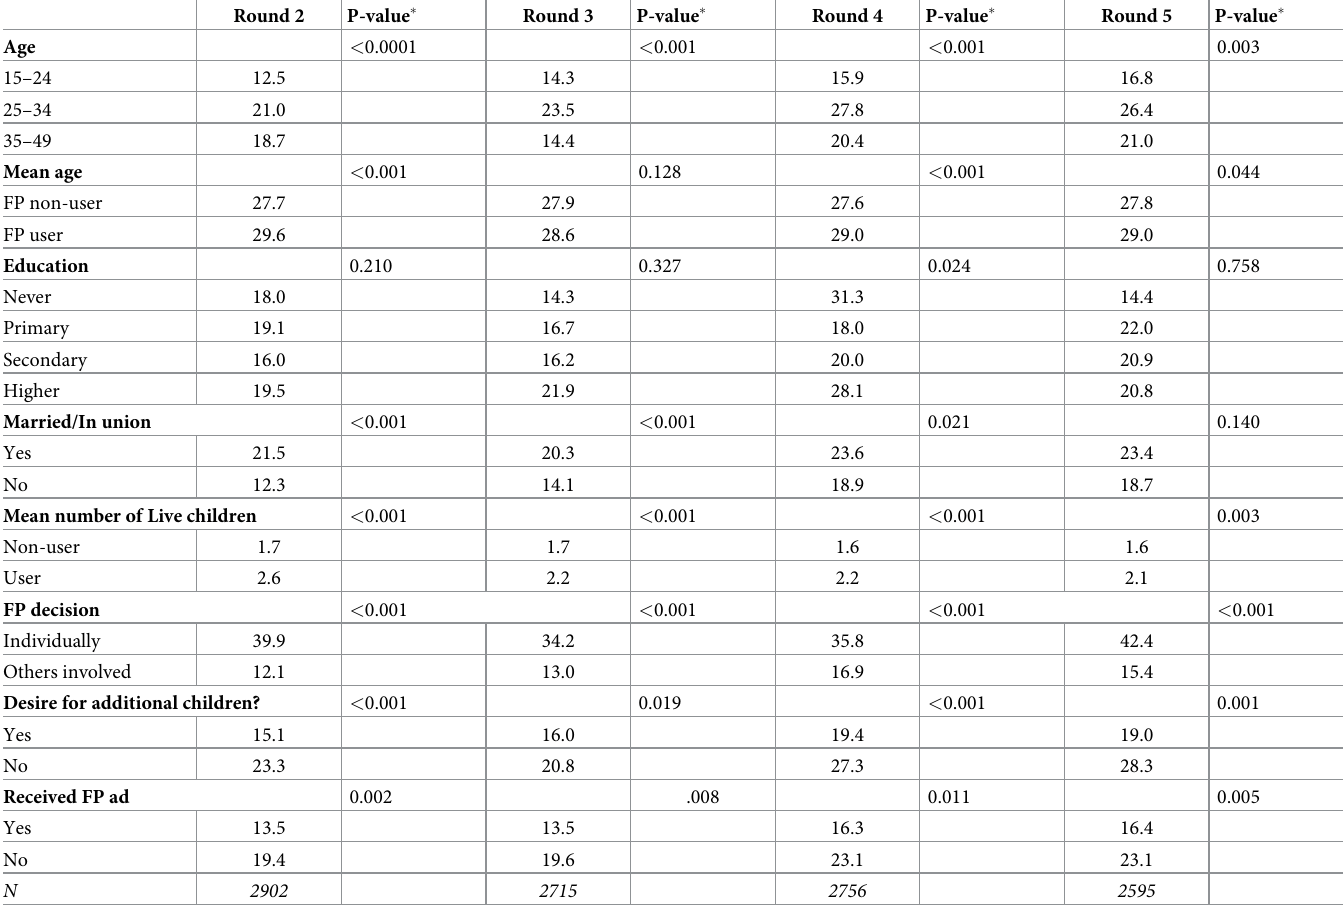
Table 4. Association between modern contraceptive use and individual characteristics, PMA2020, Kinshasa,